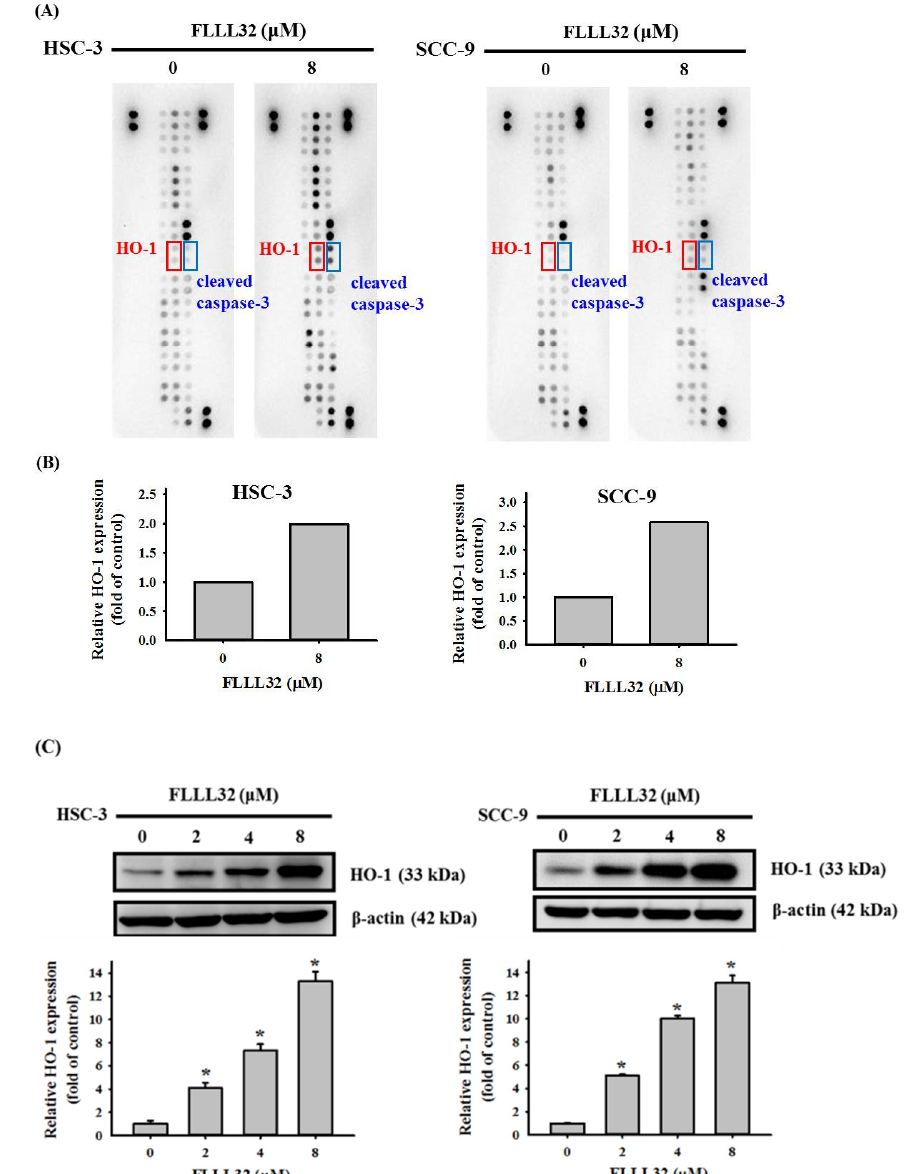
Figure 4. An increase in HO-1 is involved in the apoptosis regulated by FLLL32. ( A ) Representative images of the Human Apoptosis Array (R&D System) including 35 apoptosis-related proteins are shown for HSC-3 and SCC-9 cells after FLLL32 (8 μ M) treatment for 24 h. ( B ) The protein expression of HO-1 from the Human Apoptosis Array was quantitated using a densitometer, represented as the fold change compared to the vehicle group. ( C ) The protein expression of HO-1 after FLLL32 treatment (0, 2, 4, and 8 μ M) was also confirmed by Western blot and quantified by Image J. β -actin protein levels were used to adjust the quantitative results of protein levels; * p < 0.05 compared with the vehicle group.